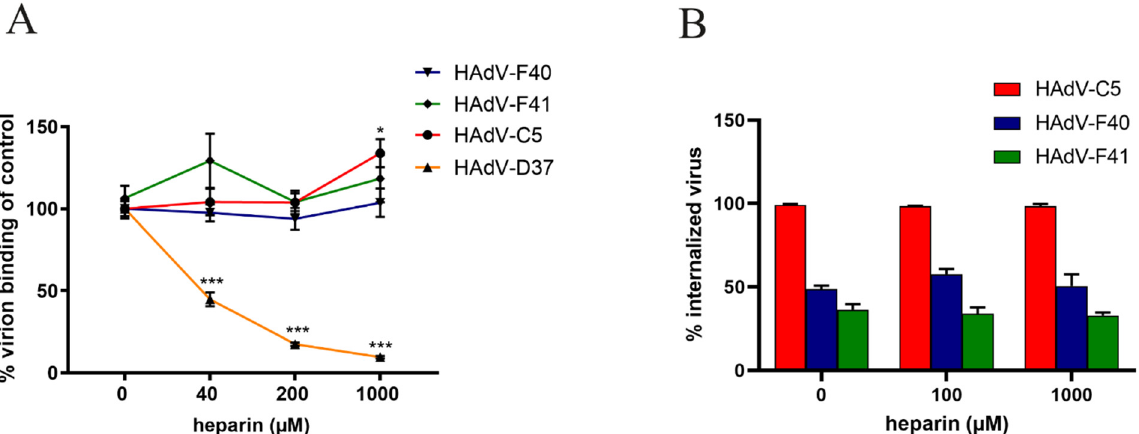
Figure 4. Effect of soluble heparin on virion binding and uptake in A549 cells. ( A ) 35 S-labeled HAdV-F40 and -F41 virion binding to A549 cells. Virions were pretreated with different concentrations of soluble heparin. Binding to cells was quantified as counts per minute (CPM) by a liquid scintillation counter and represented as % binding of untreated virions. ( B ) HAdV-C5, -F40 and –F41 uptake in A549 cells. The number of intracellular virions were quantified by immunofluorescence and shown as a relative % of internalized virus in the untreated sample. The experiments were performed three times with duplicate samples. Error bars represent mean ± SEM. * P < 0.05 and *** P < 0.001 versus control.